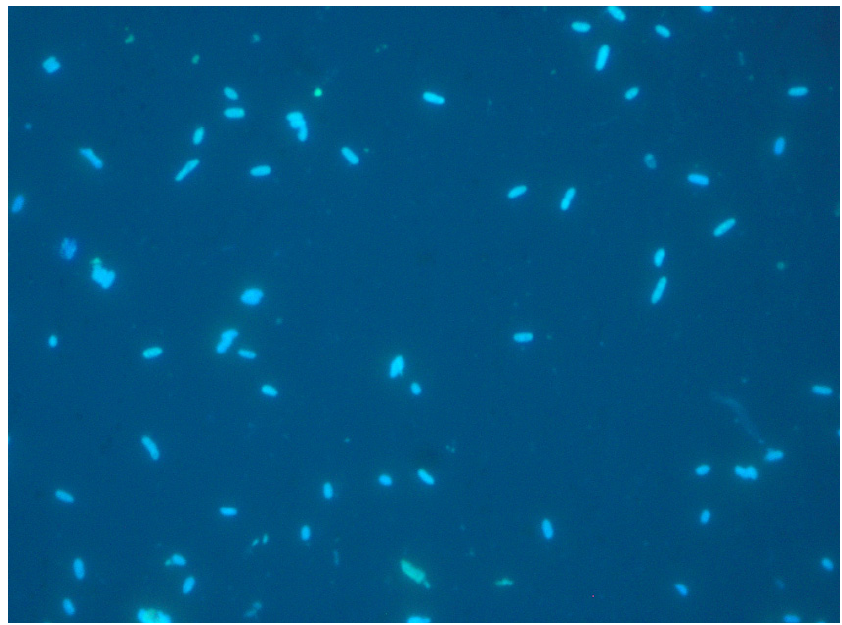
Figure 6. Pseudomonas aeruginosa biofilm on the stainless steel coupons. Stained with DAPI (0.1 mg/mL; 10 µL) (Magnification ×100).